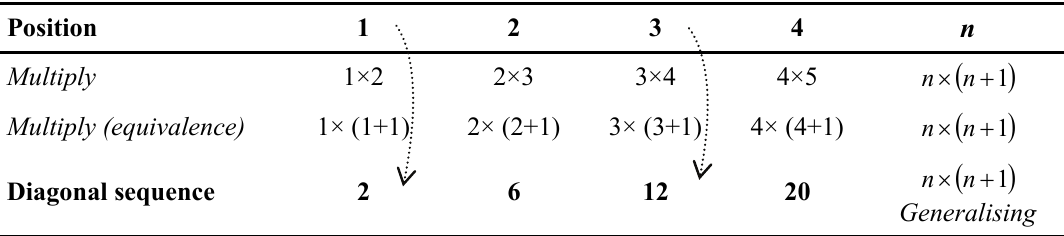
Figure 10 : Generating a formula for sequence of numbers below and above the square